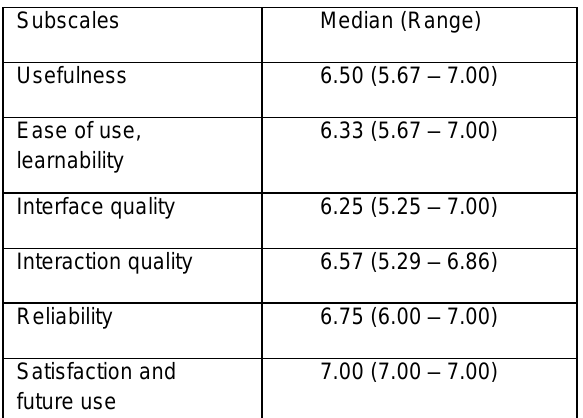
Table 3. Subscale Scores of the Telehealth Usability